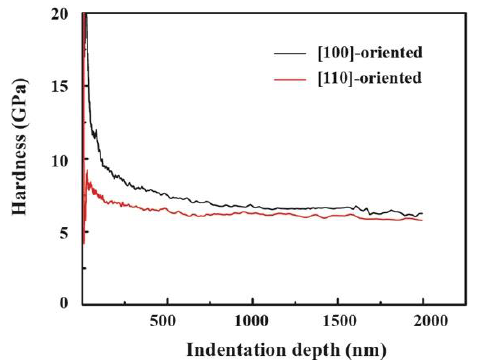
Figure 7. Hardness–indentation depth curves of the [100]- and [110]-oriented PIN–PMN–PT bulk single crystals.